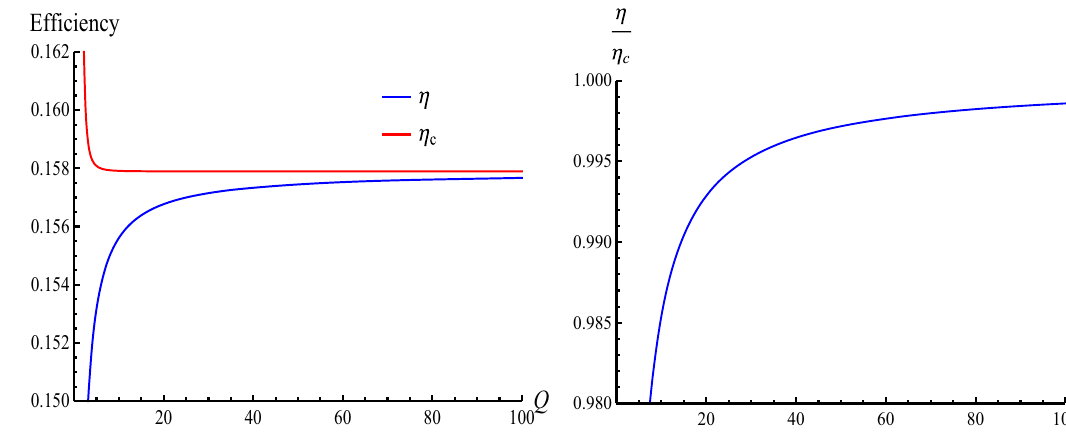
Fig. 16 The behavior of the efficiency η , the Carnot efficiency η c and the ratio η η 3 ( 1 + 24 aQ 2 P 1 = P 2 =